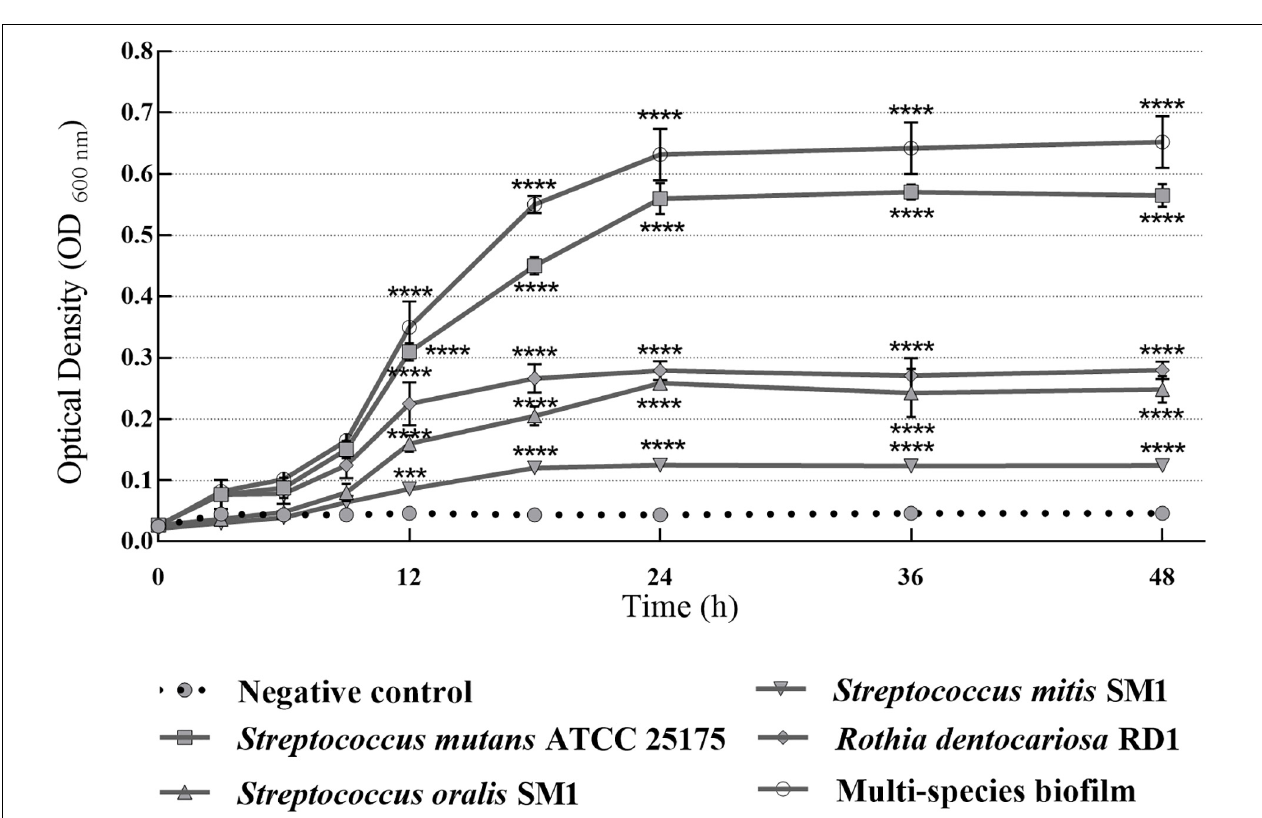
FIGURE 1 | Absorbance values of crystal violet assay with single-species and multispecies biofilms (1:1:1:1 ratio for each isolate) produced by S. mutans ATCC 25175, S. oralis SO1, S. mitis SM2 and R. dentocariosa RD1 oral isolates, plotted over time. OD 600 readings were taken after 3, 6, 9, 12, 18, 24, 36, and 48 h. The experiments were performed in triplicate with independent cultures, and statistical significance was examined by the two-way ANOVA test with Bonferroni correction. Results are indicated as means ± SDs. Asterisks indicate statistical significance (*** p < 0.001; **** p <